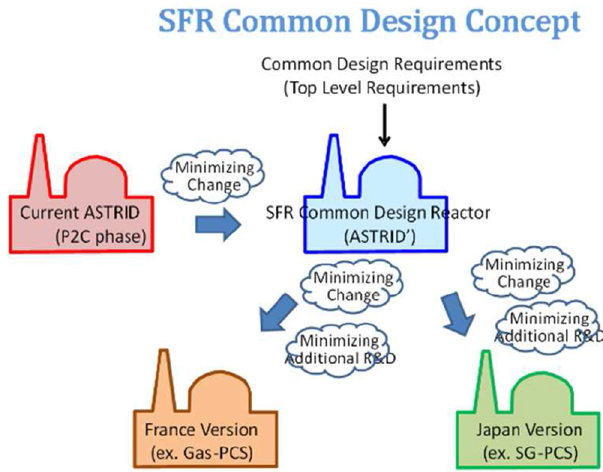
Fig. 2. SFR Common design approach.